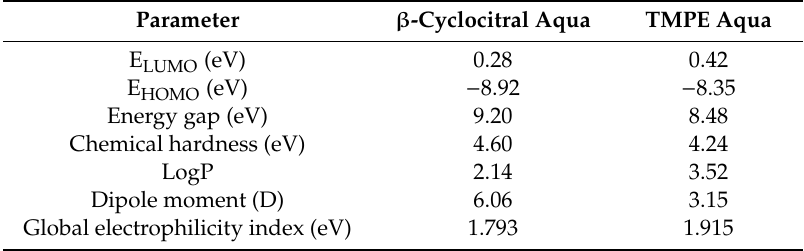
Table 2. Theoretical parameters obtained for studied compounds (in water) using the SPARTAN’18 calculation package.